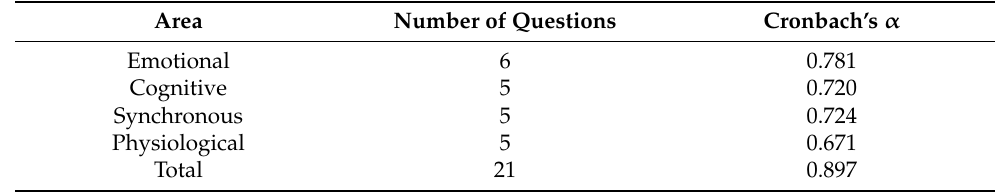
Table 4. Classification criteria for depressive